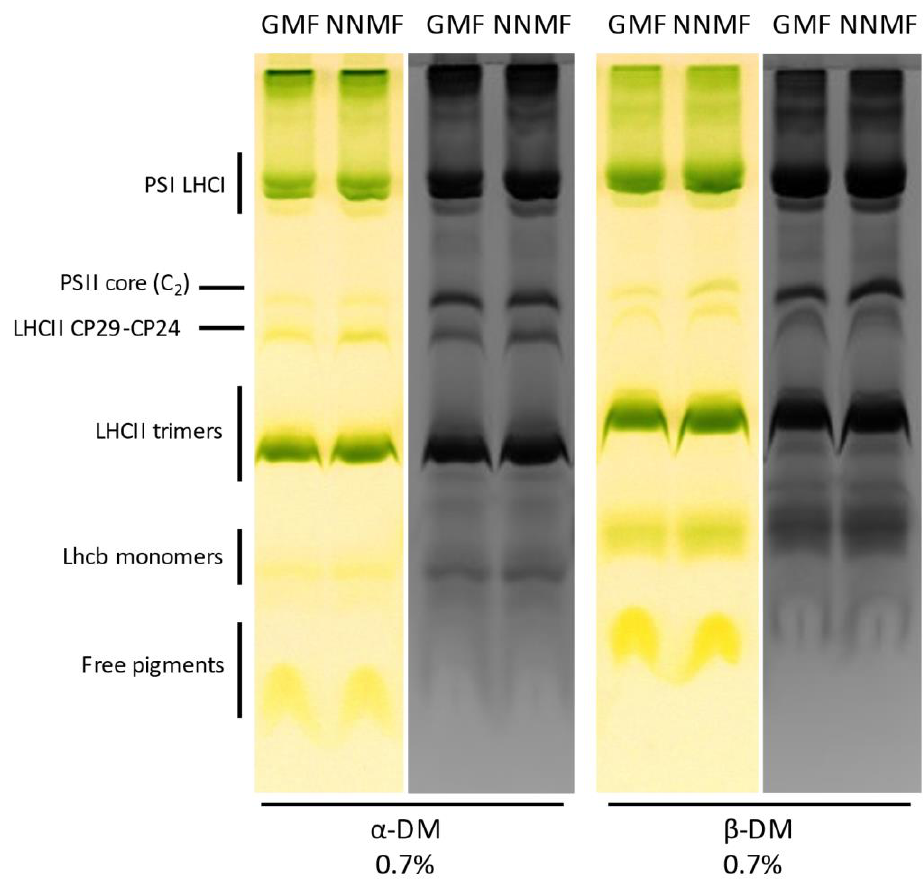
Figure 8. Analysis of membrane protein complexes in the GMF and NNMF thylakoids by Deriphat- PAGE (colored lanes), later stained with Coomassie (black and white lanes). Thylakoids have been solubilized with α-dodecyl maltoside or β-dodecyl maltoside before loading. Overall, 30 µg Chl were loaded per lane.